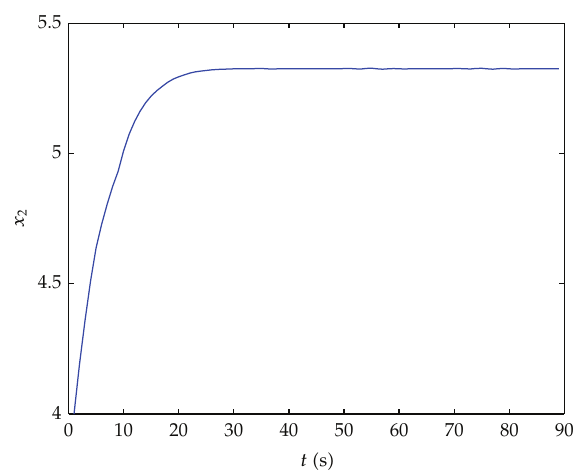
Figure 3: The trend of the predator numbers with T-S controller.